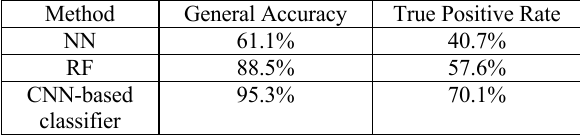
Table 1. Matching Accuracy statistics of different